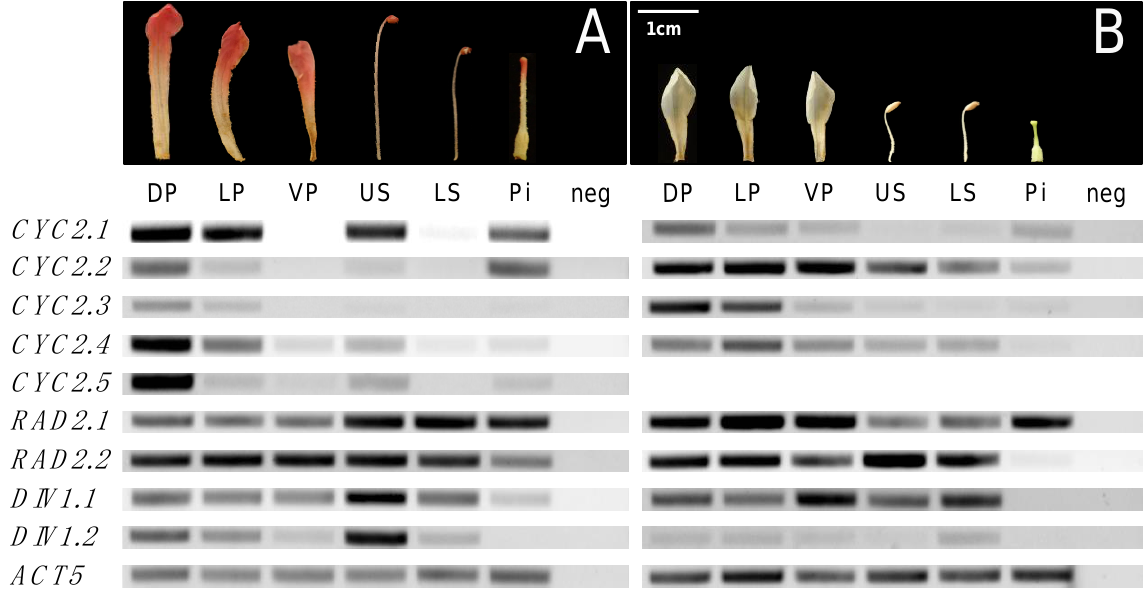
Figure 7. Gene expression of CYCLOIDEA ( CYC ), RADIALIS ( RAD ), and DIVARICATA ( DIV ) orthologs across floral organs in two Rhododendron species with different floral symmetries. Gene expression shown by RT-PCR. Floral organs sampled from late floral buds are dorsal petals (DP), lateral petals (LP), ventral petals (VP), upper stamens (US), lower stamens (LS), and pistils (Pi). Negative (neg) controls are also shown. ACTIN5 ( ACT5 ) is used as a reference gene. ( A ) Bilaterally symmetric R. beyerinckianum . ( B ) Radially symmetric R. taxifolium